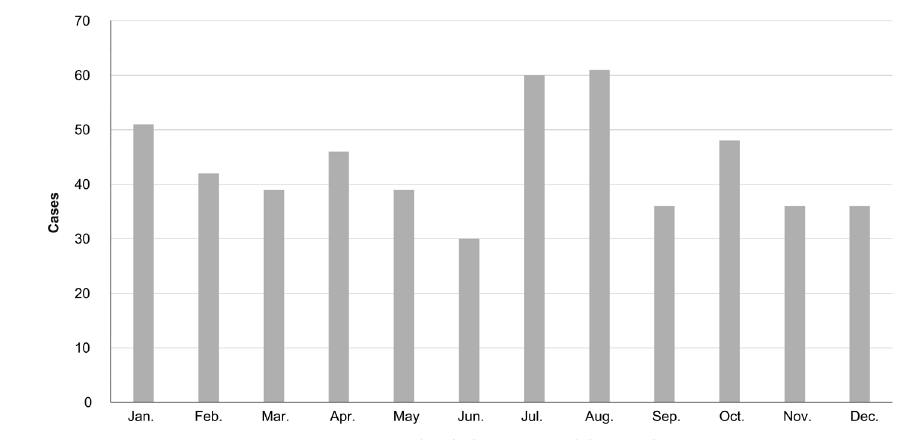
Figure 2. Frequency of Ambulance Dispatch by